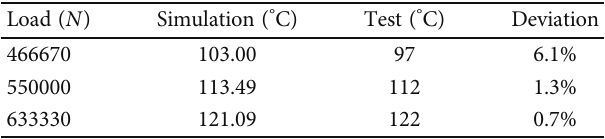
Figure 9: Temperature fi eld distribution of tire 6 # belt under loads of (a) 466667 N, (b) 550000 N, and (c) 633330 N when the in fl ation pressure is 0.6MPa, and the speed is 15km/h. Table 7: Simulation and experimental comparison of the maximum temperature of 6 # belt (0.6MPa,